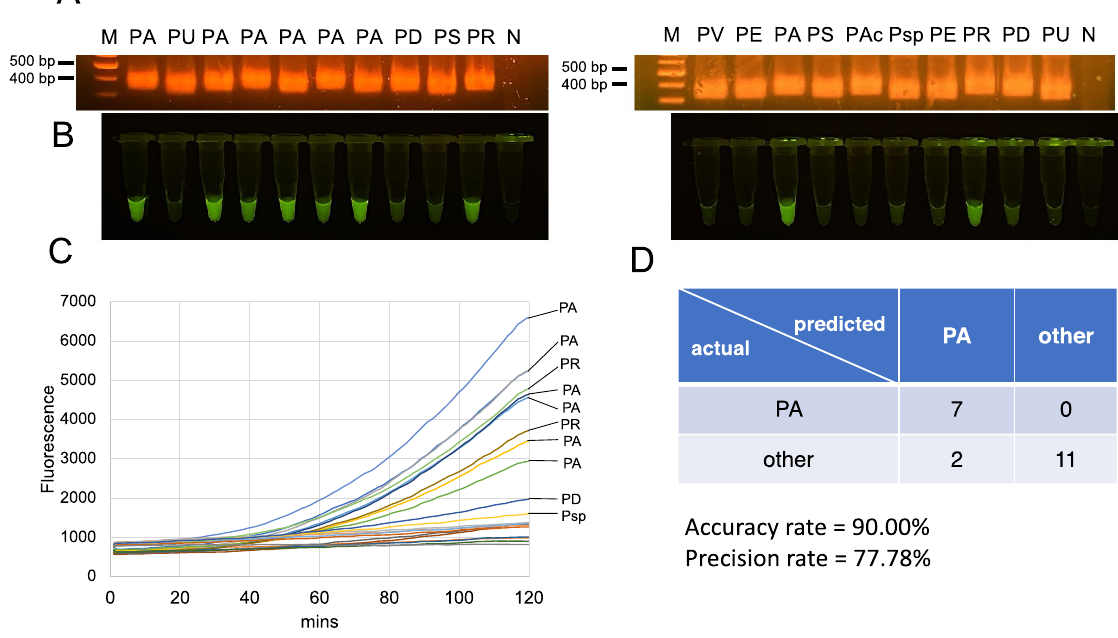
Figure 4. Accuracy test for P. amarus determination by Bar-cas12a using trnL . ( A ) DNA amplification by RPA on agarose gel of the different Phyllanthus species including P. amarus (PA), P. urinaria (PU), P. debilis (PD), P. virgatus (PV) , P. airy-shawii (PS) , P. acidus (PAc) , P. emblica (PE) , P. reticulatus (PR), Phyllanthus sp. (Psp). Cas12a assay for detecting PA-specific RPA product by naked eye under LED transilluminator ( B ) and fluorescence signal by a realtime PCR machine ( C ). ( D ) The confusion matrix of actual and predicted species with accuracy rate and precision rate of P. amarus authentication. Initial images of agarose gel electrophoresis are shown in Figure